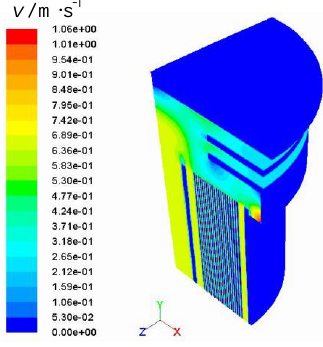
Figure 4. Air flow velocity (inlet velocity of 0.65 m/s).